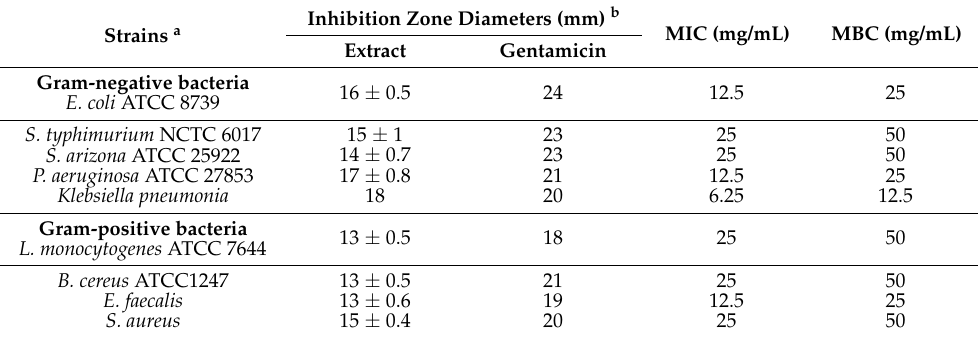
Table 4. Antibacterial activity of Marrubium vulgare methanolic extract against nine bacteria evaluated by disc diffusion and MIC and MBC tests. Inhibition Zone Diameters (mm) b MIC (mg/mL) MBC (mg/mL) Strains a Extract Gentamicin Gram-negative bacteria ± 0.5 E. coli ATCC 8739 16